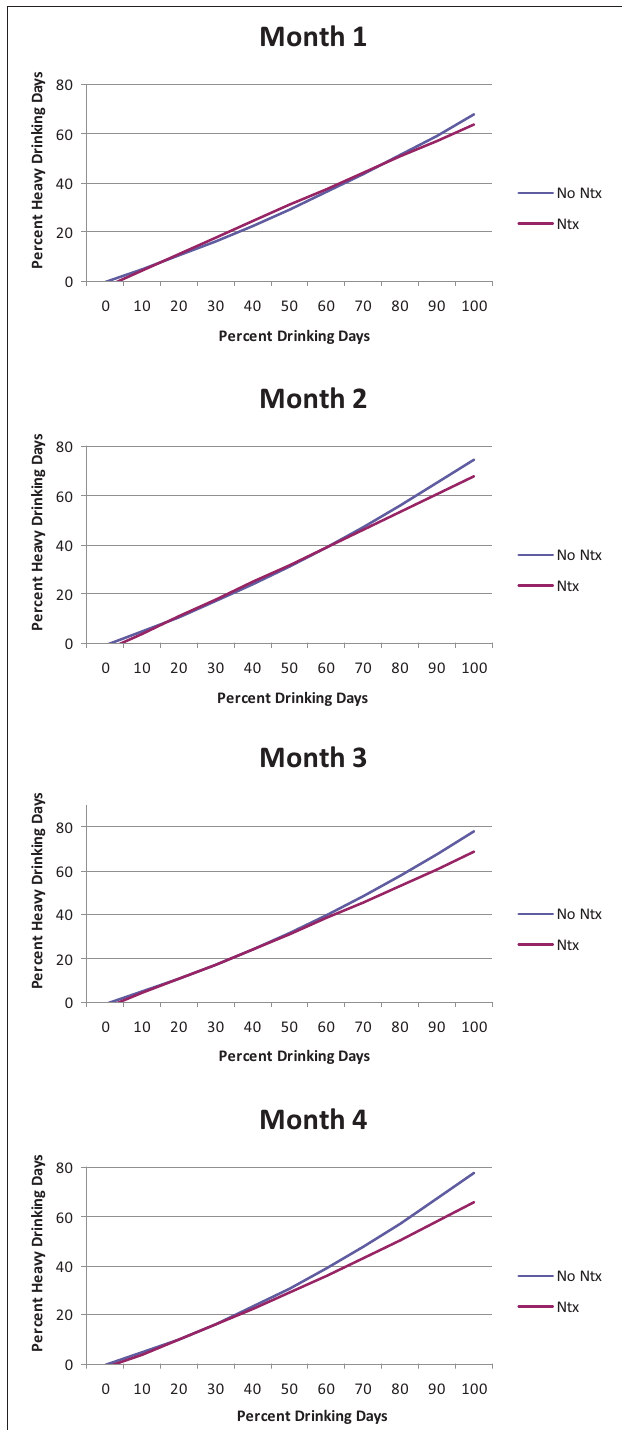
FIgurE 1 | Percent heavy drinking days (PHDD) as a function of percent drinking days (PDD) for individuals treated with naltrexone (NTX) vs. no-naltrexone across treatment months.